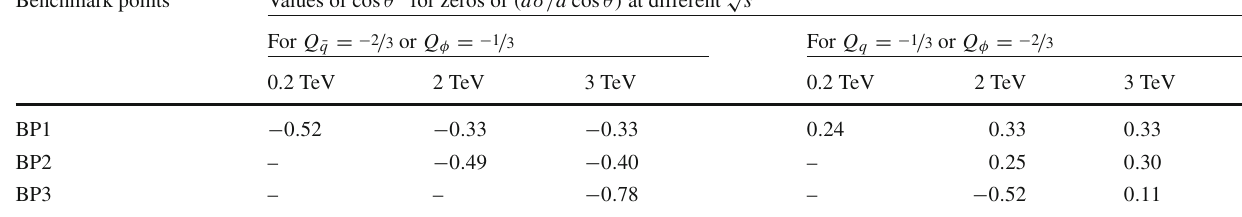
Table 5 Values of cos θ ∗ corresponding to zeros of differential cross section for production of leptoquark at different center of momentum energies for various benchmark points Benchmark points